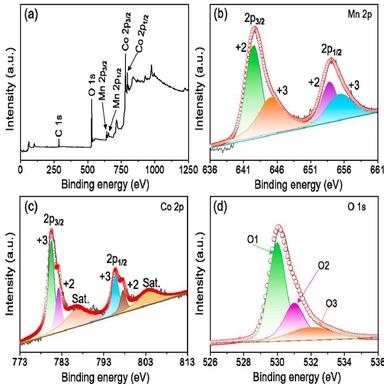
(a) XPS survey spectrum of MnCo2O4.5 nanosheets, and the core-level XPS spectra for (b) Mn 2p, (c) Co 2p, and (d) O 1 s, respectively.